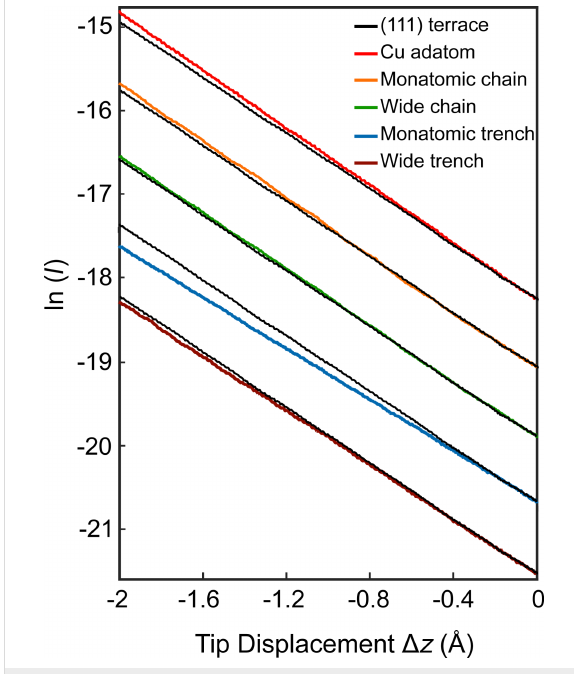
Figure 2: Current–distance data I ( Δ z ). Negative values of Δ z indicate reduced tip–sample distances with respect to the initial separation defined by I = 200 pA and V = 20 mV. Data recorded from a (111) terrace (black), a Cu adatom, a monatomic chain, a wider chain (approx. 2 atoms), and trenches of monolayer depth with single-atom and wider width (approx. 2 atoms) are displayed. The curves are arbi- trarily offset along the ordinate for clarity. The terrace data are shown with each curve for comparison. Small undulations of the data are due to low-frequency vibration of the microscope.